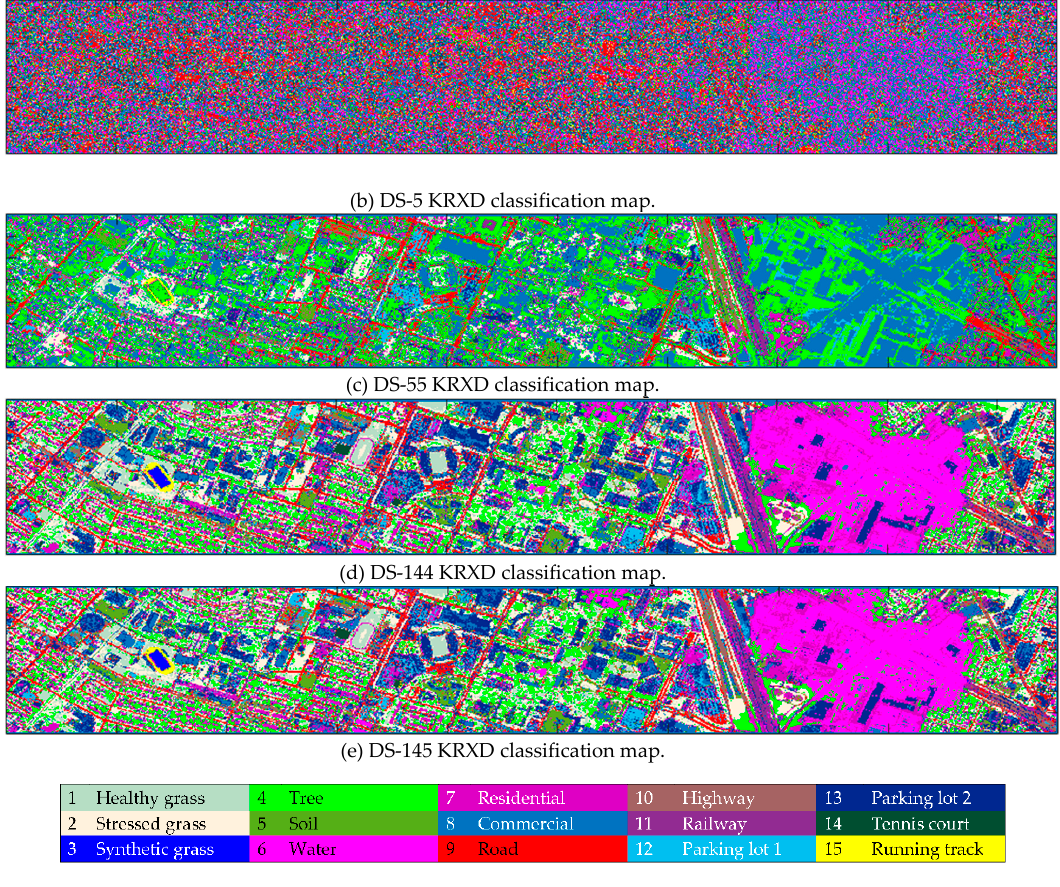
Figure A6. KRXD classification maps.